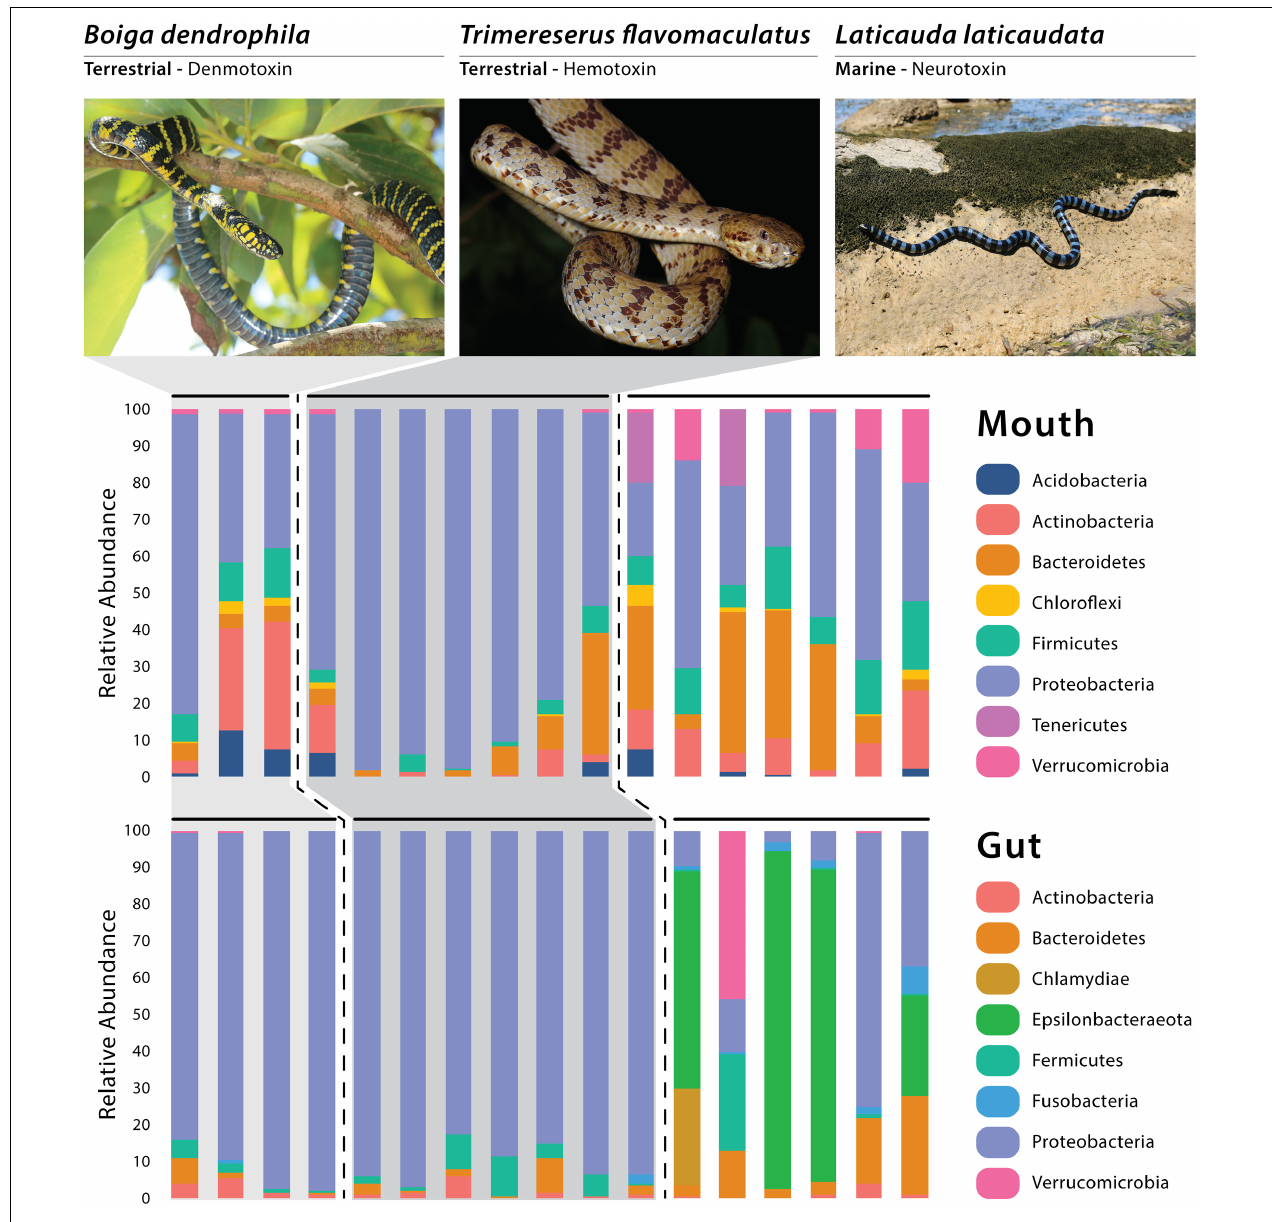
FIGURE 1 | Relative abundance of the dominant bacterial phyla recovered through 16S rRNA amplicon sequencing, with each vertical bar representing an individual swab. Photos of Boiga and Laticauda by Joseph Brown; Photo of Trimereserus by Kai Wang.